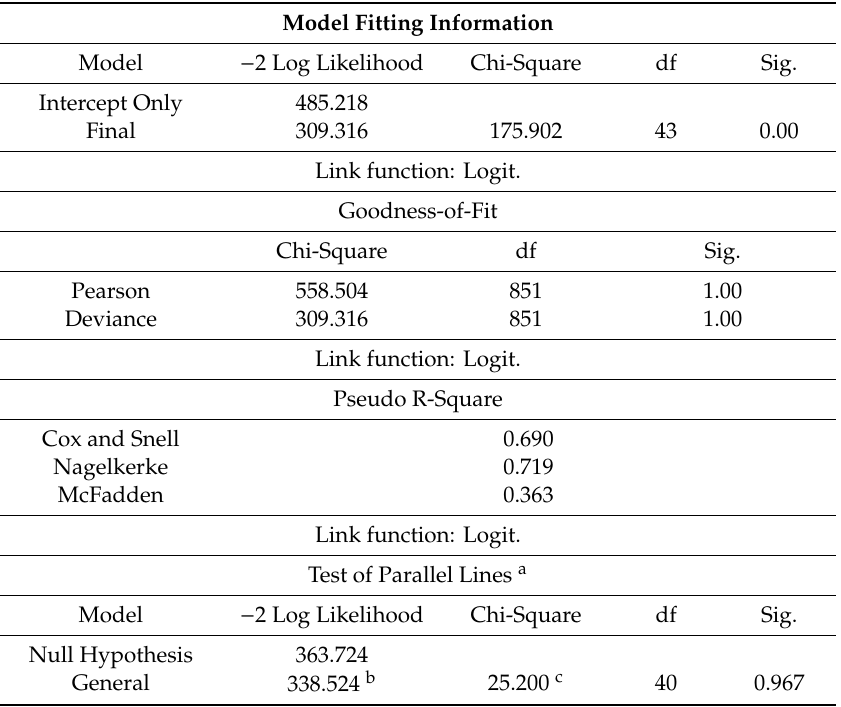
Table 2. Regression model fitting information that justifies appropriateness of the